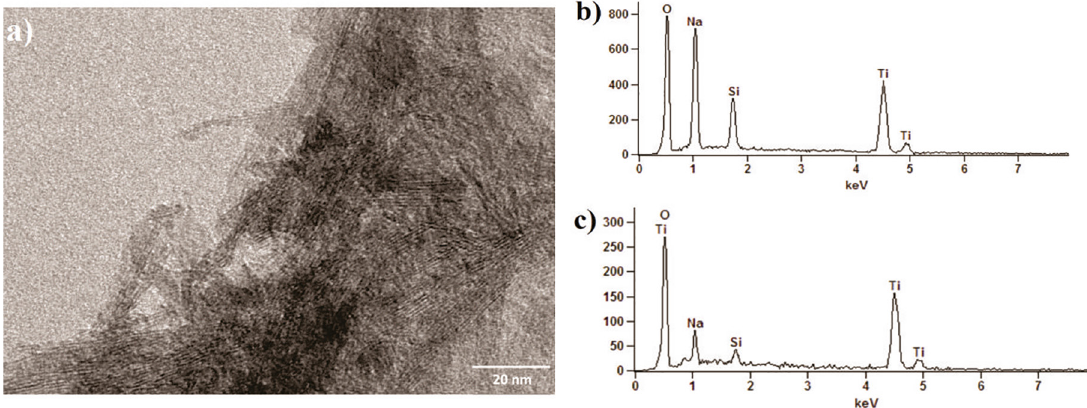
Figure 7: a) TEM image and b) EDX for the sample HMB150-30-10 as synthetized and c) EDX for the sample HMB150-30-10 after HCl